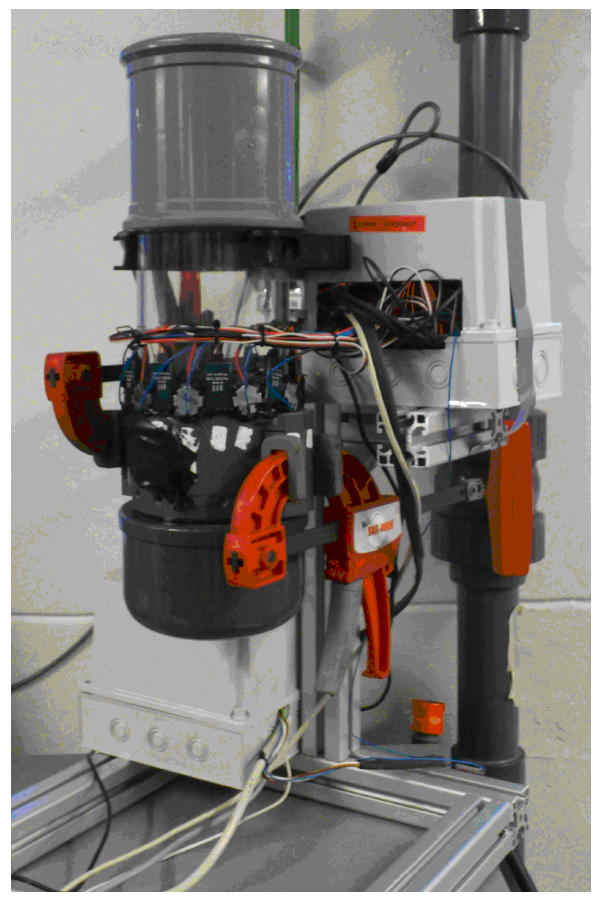
Figure 3. Mounting of the optical tomograohy device on a vertical Fig. 3 : Mounting of the optical tomograohy device on a vertical end of transparent pipe. end of transparent